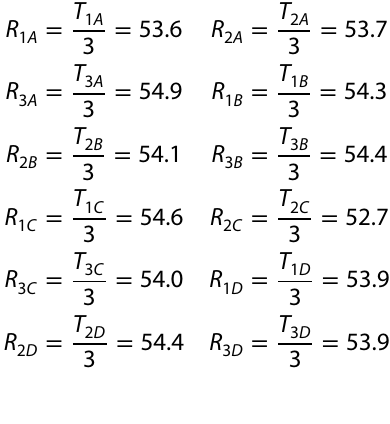
Fig. 5 The influence trend of hook position horizontal value on interior